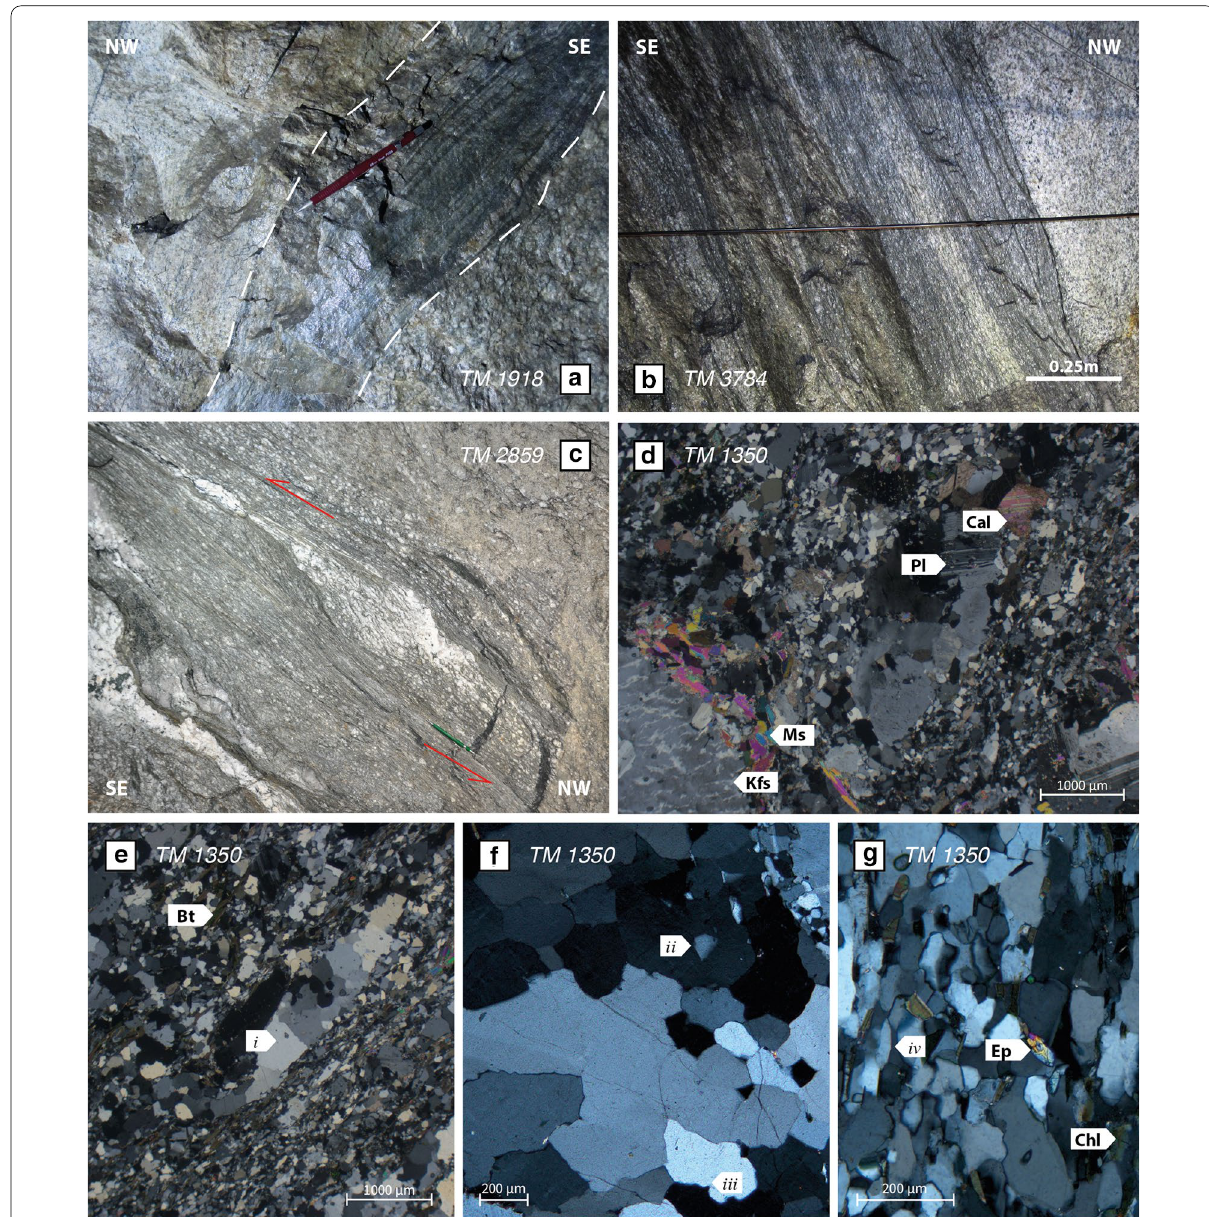
Fig. 10 Field photographs and photomicrographs of G-SZ. a Strain localization at the boundary between coarser grained granite in the SE and finer grained granite in the NW, pencil for scale. b G-SZ in the meter range, as typically observed between TM 2800 and the NW terminus of the tunnel (TM 5218). c Shear sense indication by sigmoidal aggregate, pencil for scale. d – g Thin section cutouts of a G-SZ at TM 1350. The italic roman numbers correspond to descriptions related to dynamic recrystallization (Sect. 3.2.4): ( i ) quartz in coarse-grained domain surrounded by fine-grained bands, ( ii ) ‘island’ grain in coarse-grained domain, ( iii ) irregular grain boundary in coarse-grained domain, ( iv ) elongated quartz grain in fine-grained